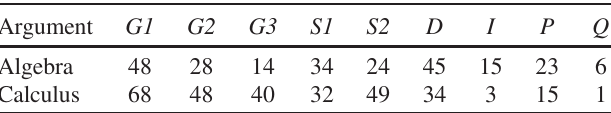
TABLE VII. Prevalence of arguments, expressed as percent- ages. For the algebra-based cohort N ¼ 1224 and for the calculus-based cohort N ¼ 944